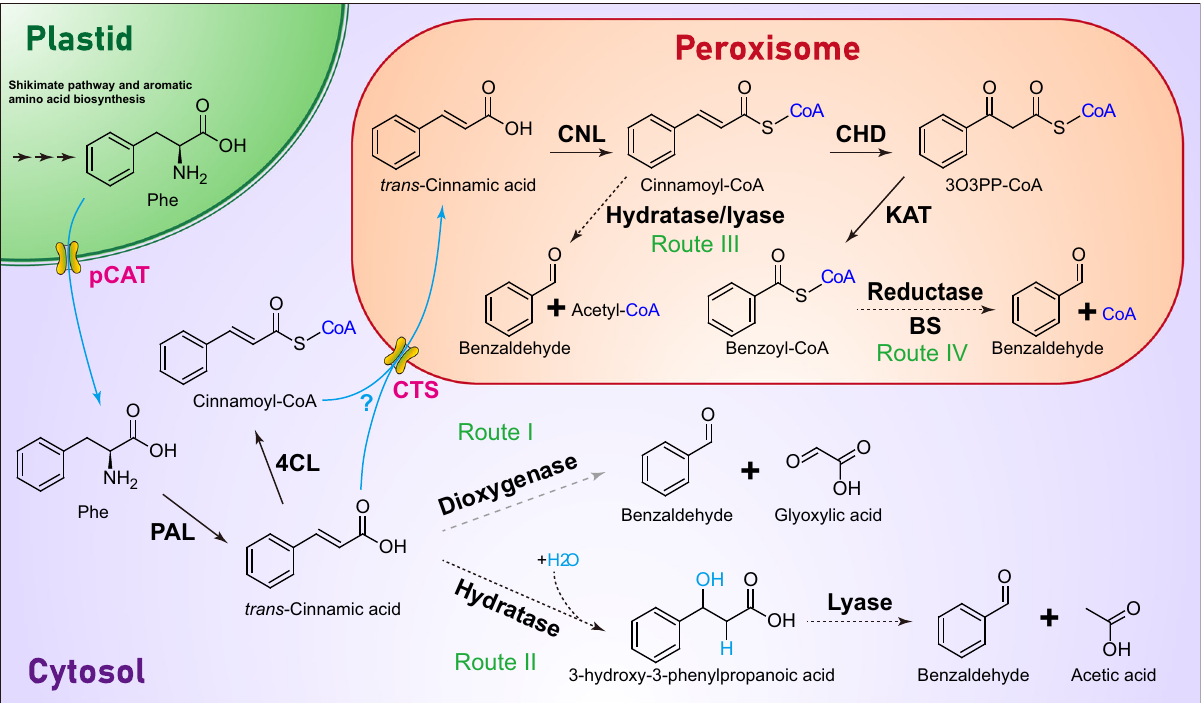
Fig. 1 Proposed pathways for benzaldehyde biosynthesis in plants. Enzymes responsible for each biochemical reaction are shown in bold black. Solid black arrows show biochemical steps with their encoding genes discovered, dashed black arrows show steps established only at enzyme level and dashed gray arrow presents putative step. Cinnamoyl-CoA formation is also shown in the cytoplasm since 4CL enzymes capable of activating trans -cinnamic acid were reported in some plants 19,31 . Transporters involved in metabolite transport between different subcellular locations are in bold magenta, with the fl ow of metabolites indicated by cyan arrows. CHD cinnamoyl-CoA hydratase/dehydrogenase, CNL cinnamate-CoA ligase, CTS peroxisomal cinnamic acid/ cinnamoyl-CoA transporter COMATOSE. The substrate speci fi city of CTS is unclear, as indicated by a cyan question mark; KAT 3-ketoacyl thiolase, PAL phenylalanine ammonia lyase, pCAT plastidial cationic amino acid transporter, Phe phenylalanine, 3O3PP-CoA